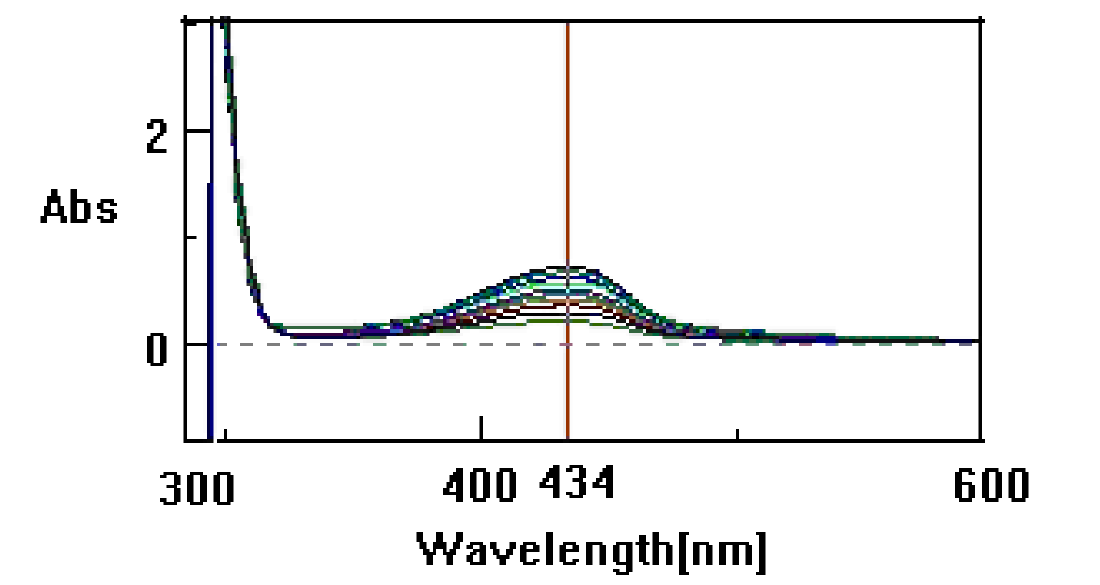
Fig. 2 UV/VIS spectra of the reaction mixture. Conditions: 0.01 M phosphate bu¬er, pH 6.00, 0.00445 M substrate at 30¸C